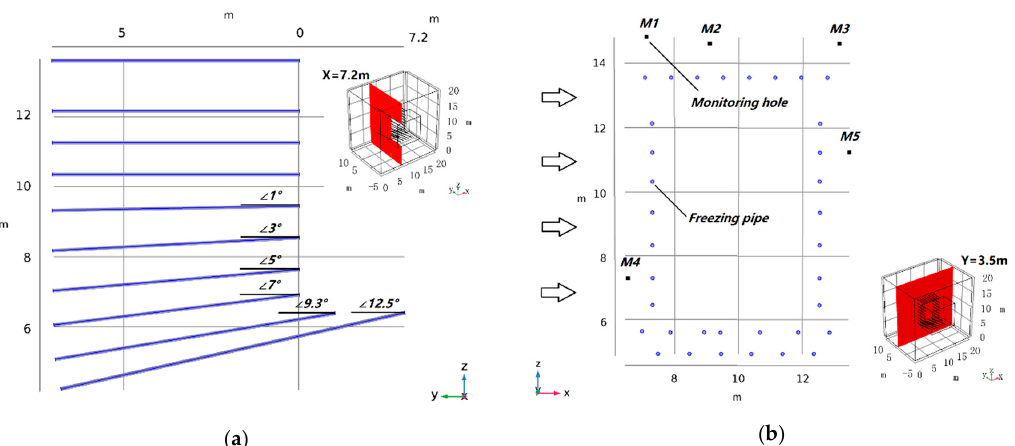
Figure 8. The arrangement of freezing pipes and monitoring points in three-dimensional (3D) model. ( a ) Side view with blue lines representing the freezing pipes; ( b ) Front view (the arrows represent groundwater flow direction).